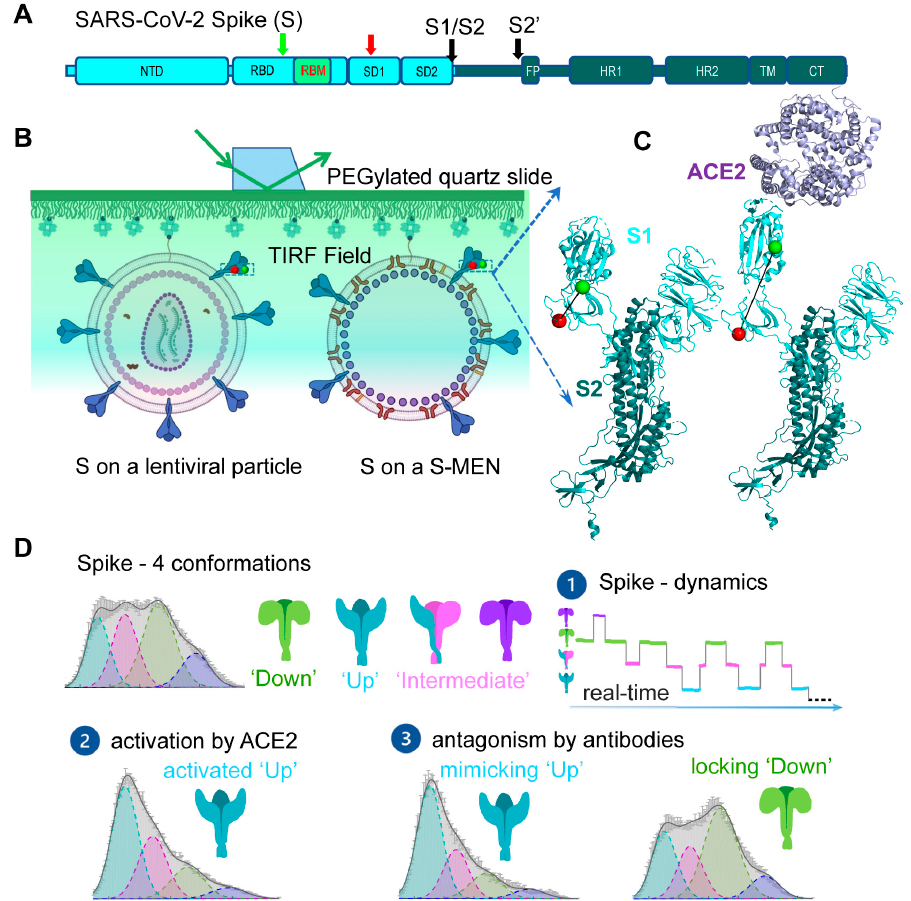
Figure 3. Conformational modulations of dynamic SARS-CoV-2 spike (S) proteins by receptors and antibodies. ( A ) Domain organization of full-length wild-type SARS-CoV-2 S (S1, cyan; S2, dark blue). Green and red arrows indicate the Cy3- and Cy5-labeling sites, respectively. Black arrows indicate protease cleavage sites (S1/S2 and S2 (cid:48) ). NTD, N-terminal domain; RBD, receptor-binding domain; RBM, receptor-binding motif; SD1, subunit domain 1; SD2, subunit domain 2; FP, fusion peptide; HR1/HR2, heptad repeat 1/heptad repeat 2; TM, transmembrane domain; CT, cytoplasmic tail. ( B , C ) smFRET imaging experimental set-up. ( B ) Virus particles carrying a fluorescently labeled SARS-CoV- 2 S protomer among wild-type spikes were immobilized and imaged on a PEG/PEG–biotin-coated PEGylated quartz slide on a prism-based TIRF microscope. The same type of experimental strategy has been used in other virus spike proteins throughout this review. For SARS-CoV-2, two virus particle systems were used to carry S on the surface. HIV-1 lentivirus particles are composed of HIV-1 cores and S proteins on the surface. S-MEN comprises four structural proteins of SARS-CoV-2 (S, spike; M, membrane protein; E, envelope protein; and N, nucleocapsid protein. ( C ) The binding of the cellular receptor human angiotensin-converting enzyme 2 (hACE2) induces conformational changes of S from the “RBD-down” (based on PDB:6VSB) to the “RBD-up” (PDB: 6VYB/6M0J) conformation. Cy3-labeling site, green ball; Cy5-labeling site, red ball; S1, light cyan; S2, dark blue; hACE2, magenta. ( D ) Featured findings of S conformations by smFRET imaging. These findings include (1) S dynamically samples four different conformations in real time, and S is in equilibrium exchange between states; (2) the binding of receptor hACE2 shifts S from the ground state (“RBD- down”) to the activated state (“RBD-up”) via an on-path intermediate (existing in the asymmetric S); (3) antibodies can antagonize S either by directly competing with receptor for the binding to S or by stabilizing S in the ground state